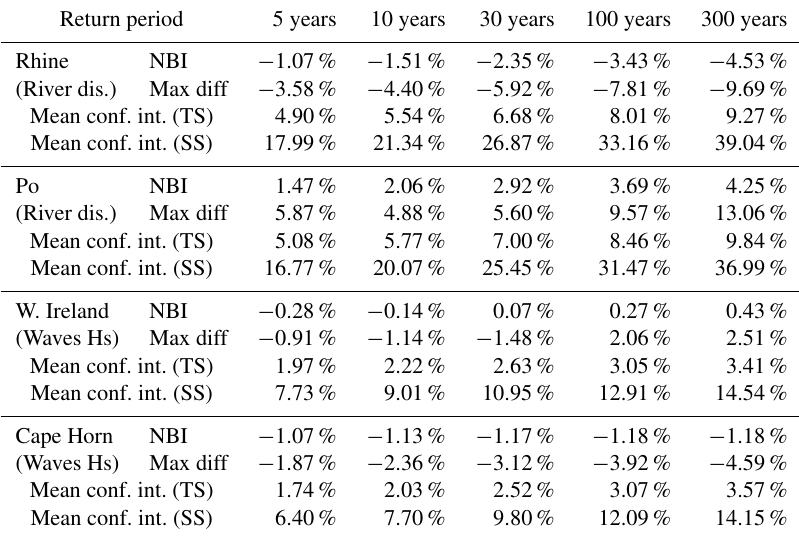
Table 3. Long-term variations of the extremes of projected river discharge for the Rhine and Po rivers, and of projected significant wave height for west Ireland and Cape Horn: normalized bias (NBI) and maximum difference (max diff) between the return levels estimated with the TS methodology and the SS approach, and mean 95% confidence interval amplitude expressed as percentage of the return level, for return periods of 5, 10, 30, 100, and 300